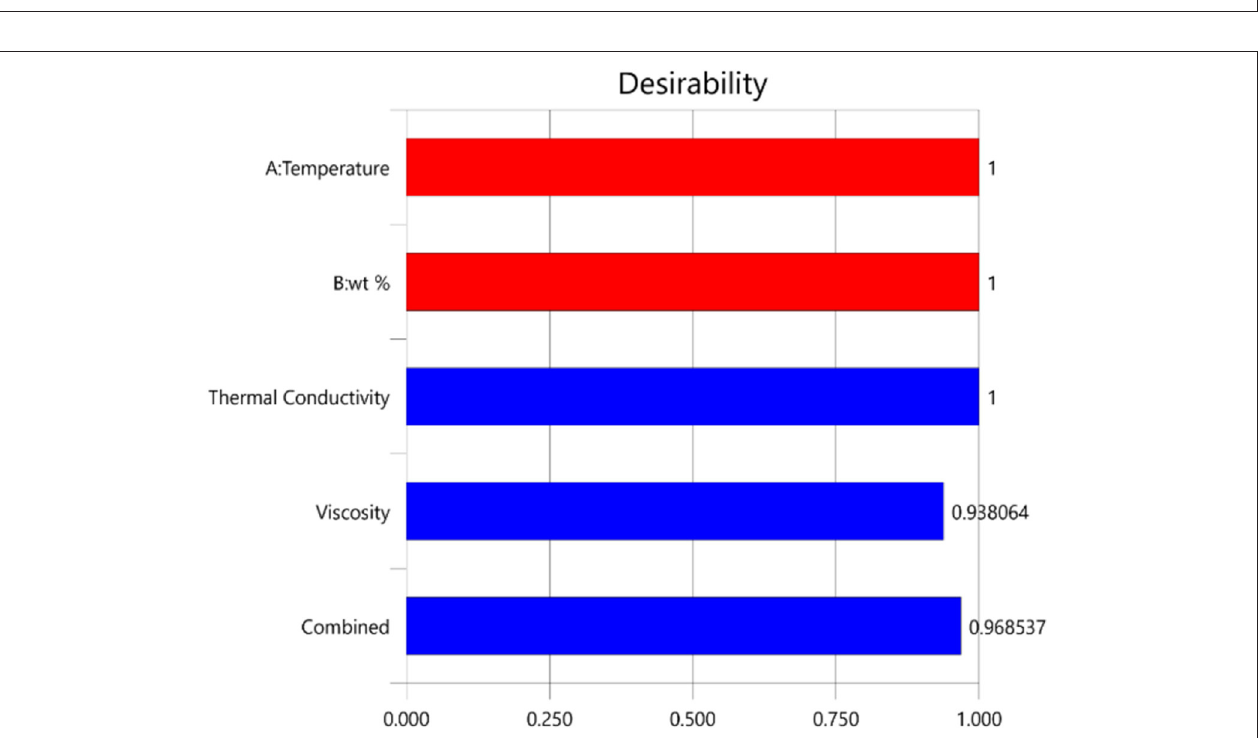
FIGURE 5 | Ramp function the optimized solution.